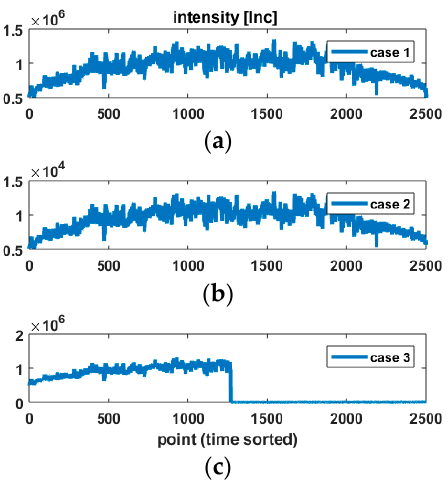
Figure 2. The three intensity vectors retained for the simulations. The intensity values in [Inc] are sorted per point, i.e., per time. 2500 points were measured. Intensity vector ( a ) Int ref corresponds to an original vector from an arch bridge; ( b ) Int ref /100; ( c ) a two part intensity vector built as a mix between case 1 and case 2.